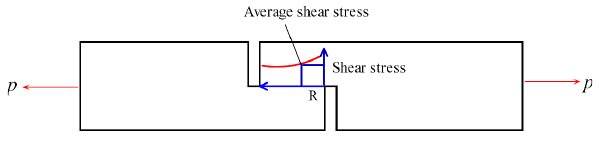
Figure 9: Schematic diagram of the characteristic length determina- tion method